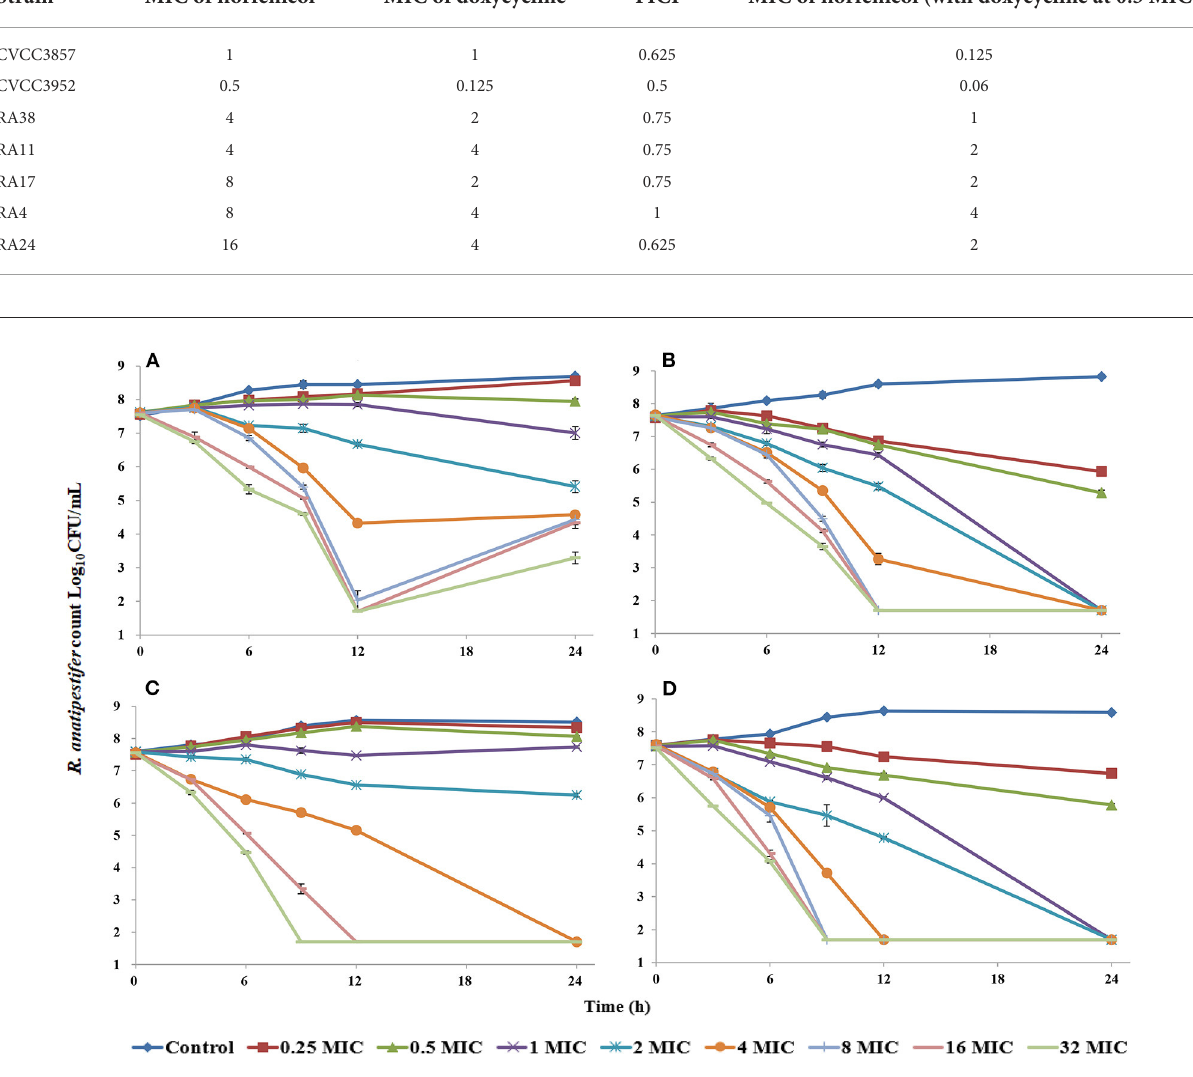
FF, a bactericidal effect was not observed at any dose within 24